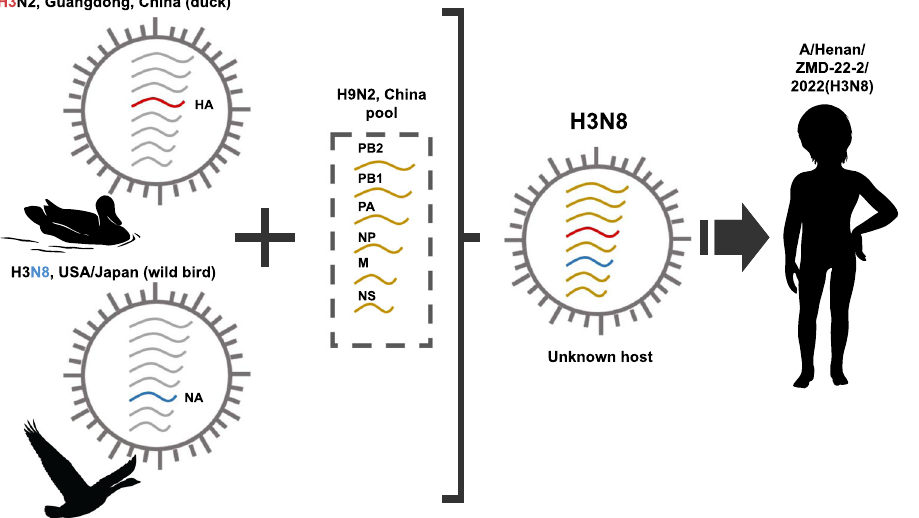
Fig. 4 | Hypothetical reassortment route and segment origins of the A (H3N8) in fl uenza virus. The colors of the segments indicate their